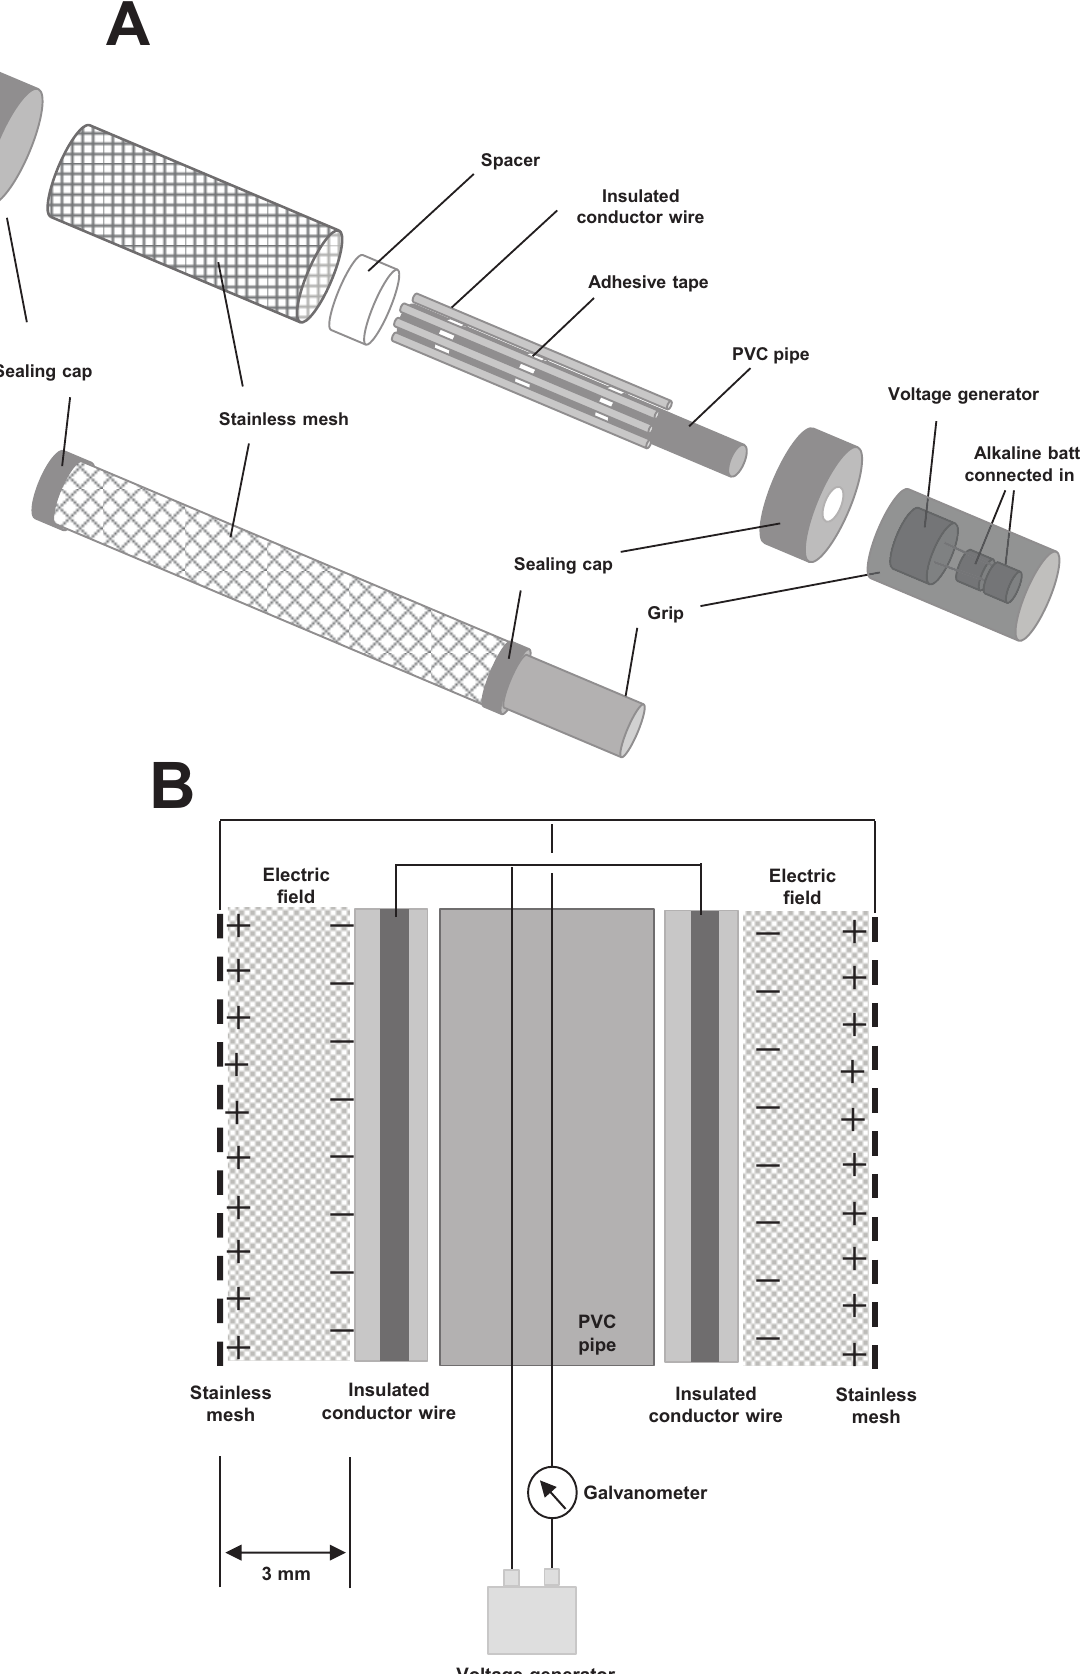
Figure 1. Diagrams of an electrostatic insect sweeper ( A ) and the electrostatic details in the formation of an electric field ( B